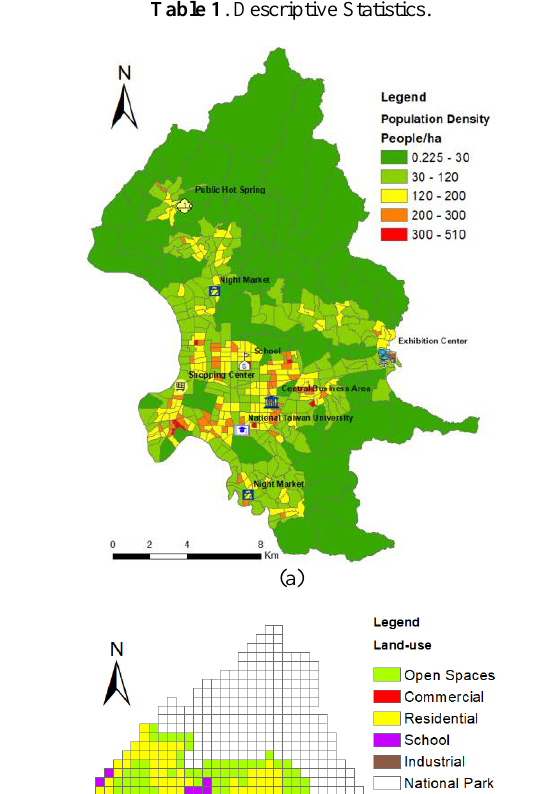
Table 1 . Descriptive Statistics.